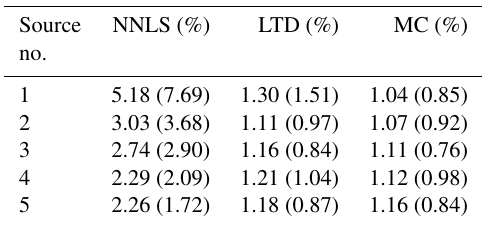
tion becomes more uniform with larger numbers of sources. Table 3. Mean and standard deviation of the exposure